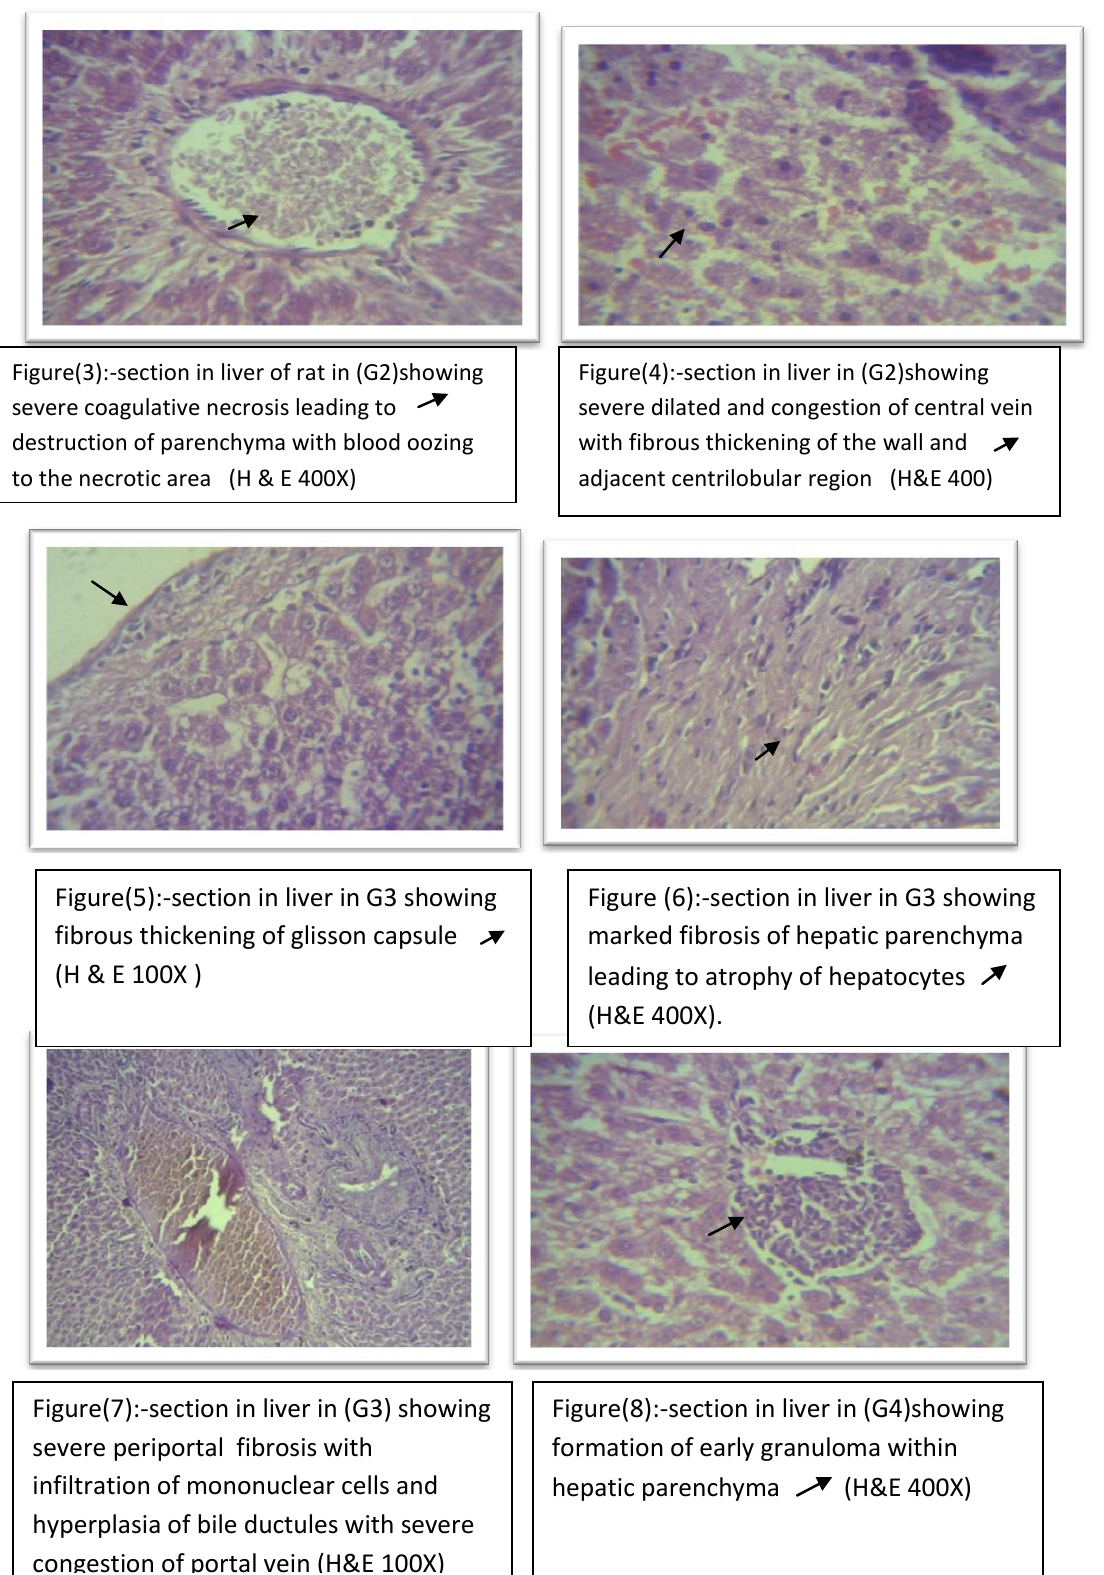
Figure(7):-section in liver in (G3) showing severe periportal fibrosis with infiltration of mononuclear cells and hyperplasia of bile ductules with severe congestion of portal vein (H&E 100X)